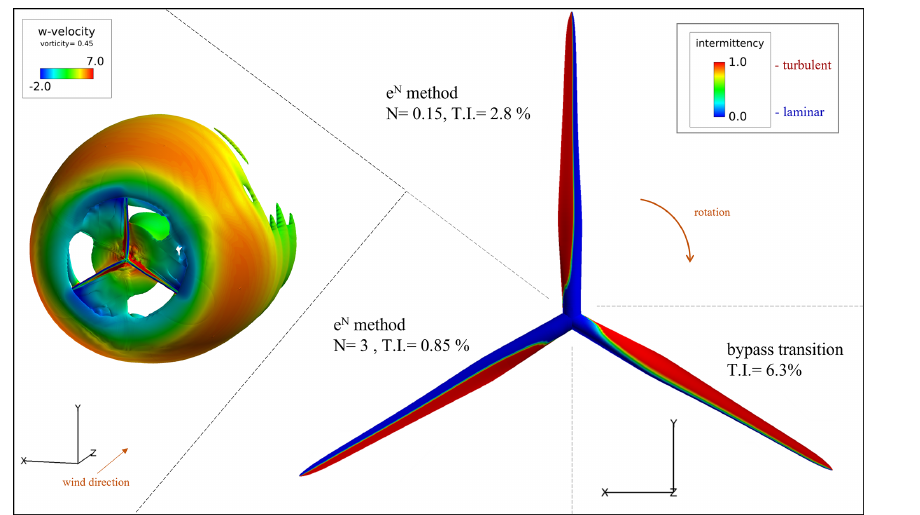
Figure 15. EllipSys3D-vorticity iso-surfaces colored by the w velocity (wind direction) component (on the left) and intermittency γ contours on the pressure side obtained for three different inflow turbulence levels with natural and bypass transition models, shown in the same figure for representing the change of the transition line location throughout a single revolution (on the right) ( w = 6 . 3ms − 1 ).